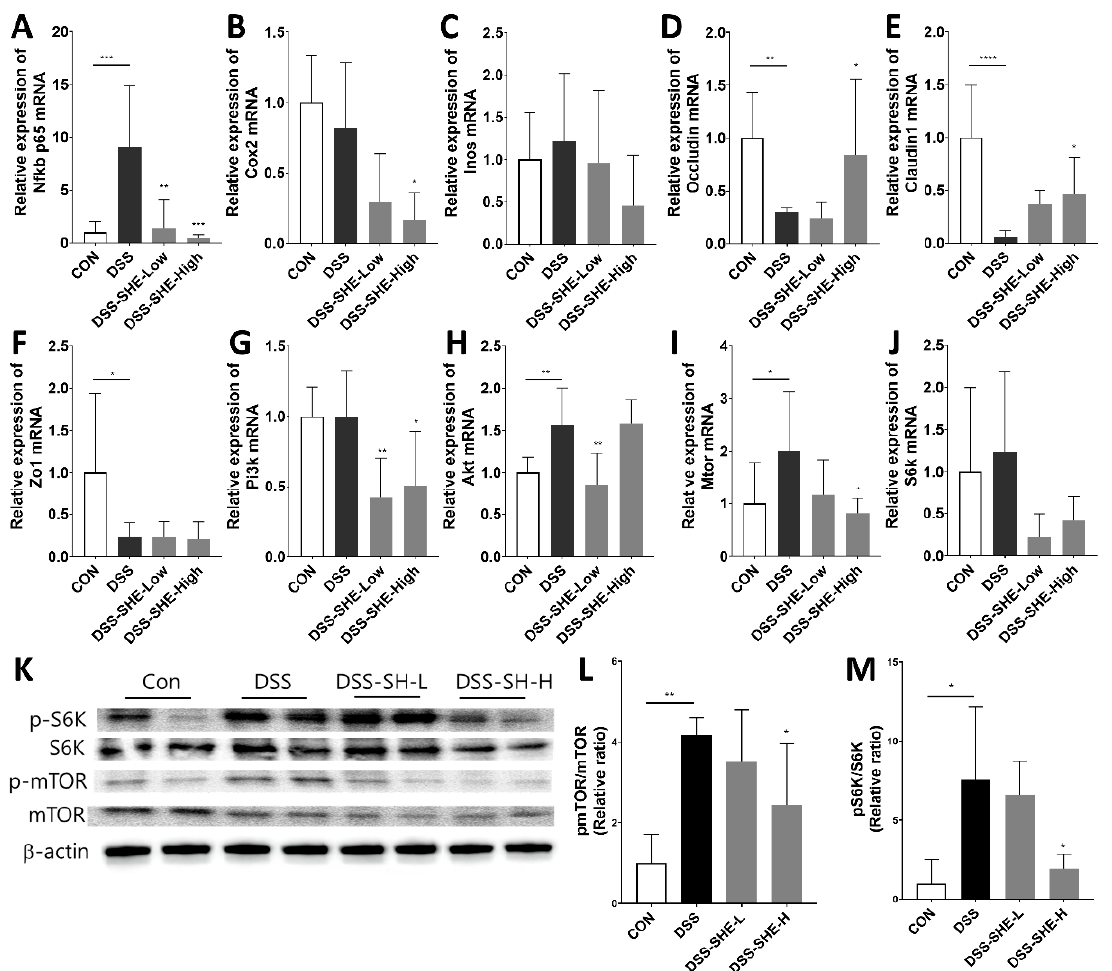
Figure 6. Effects of S. horneri extract (SHE) on inflammatory markers, tight junctions, and mTOR axis in DSS-treated mice. Gene expression of ( A ) Nfkb p65 , ( B ) Cox2 , ( C ) Inos , ( D ) Occludin , ( E ) Claudin1 , ( F ) Zo1 , ( G ) Pi3k , ( H ) Akt , ( I ) Mtor , and ( J ) S6k mRNA in the colon of DSS-treated mice. As a reference gene, β -actin was utilized. ( K ) Western blotting was used to determine the expression of p-mTOR, mTOR, p-S6K, S6K, and β -actin in colonic tissues, as well as the relative ratios of ( L ) p- mTOR/mTOR and ( M ) p-S6K/S6K were calculated. All data are expressed as means ± SD ( n = 8). * p < 0.05, ** p < 0.01, *** p < 0.001, **** p < 0.0001, significantly different compared with DSS group by one way ANOVA followed by Dunnett’s test. CON: control group; DSS: 2.5% DSS in drinking water for the last 7 days; DSS-SHE-L: DSS + S. horneri extract low dose group (100 mg/kg bw/day); DSS- SHE-H: DSS + S. horneri extract high dose group (200 mg/kg bw/day).